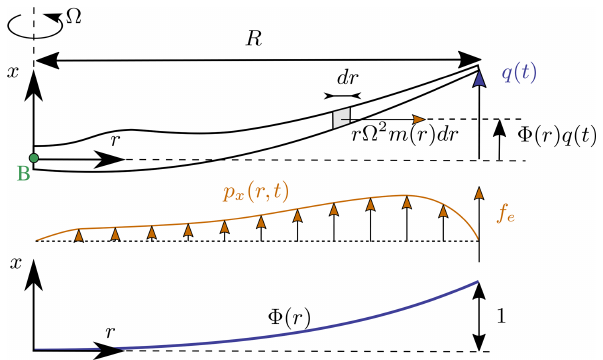
Figure 2. Sketch of a rotating blade with the restoring centrifugal force. Points are indicated in green, degrees of freedom in blue, and loads in